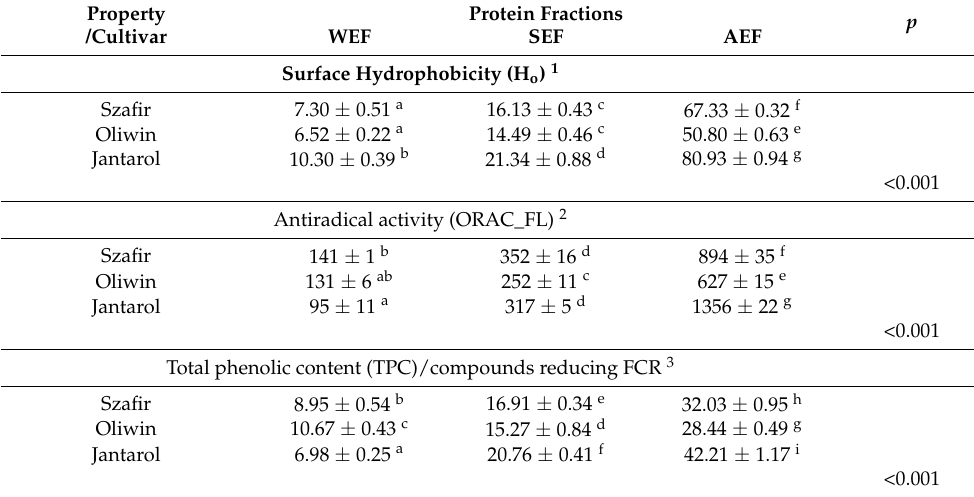
Table 3. Functional properties of the flaxseed protein